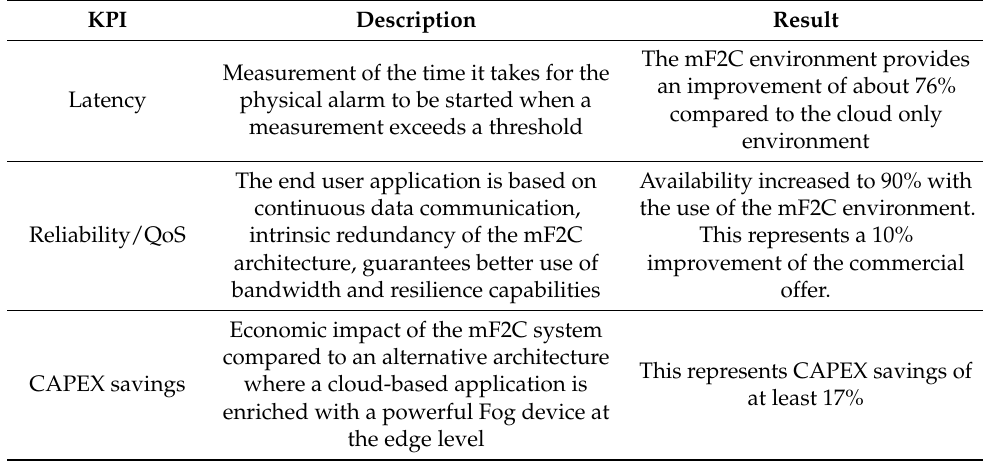
Figure 2. mF2C deployed at the ESM use case. Table 2. KPIs summary for the ESM use